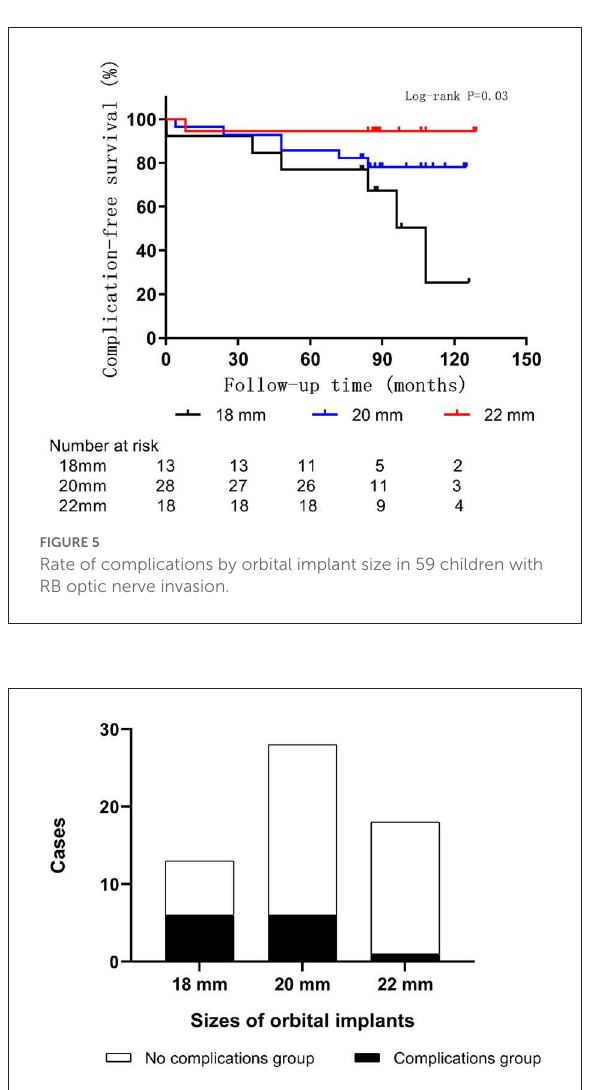
FIGURE6 Complications in RB optic nerve invasion of patients with different sizes of orbital implants.